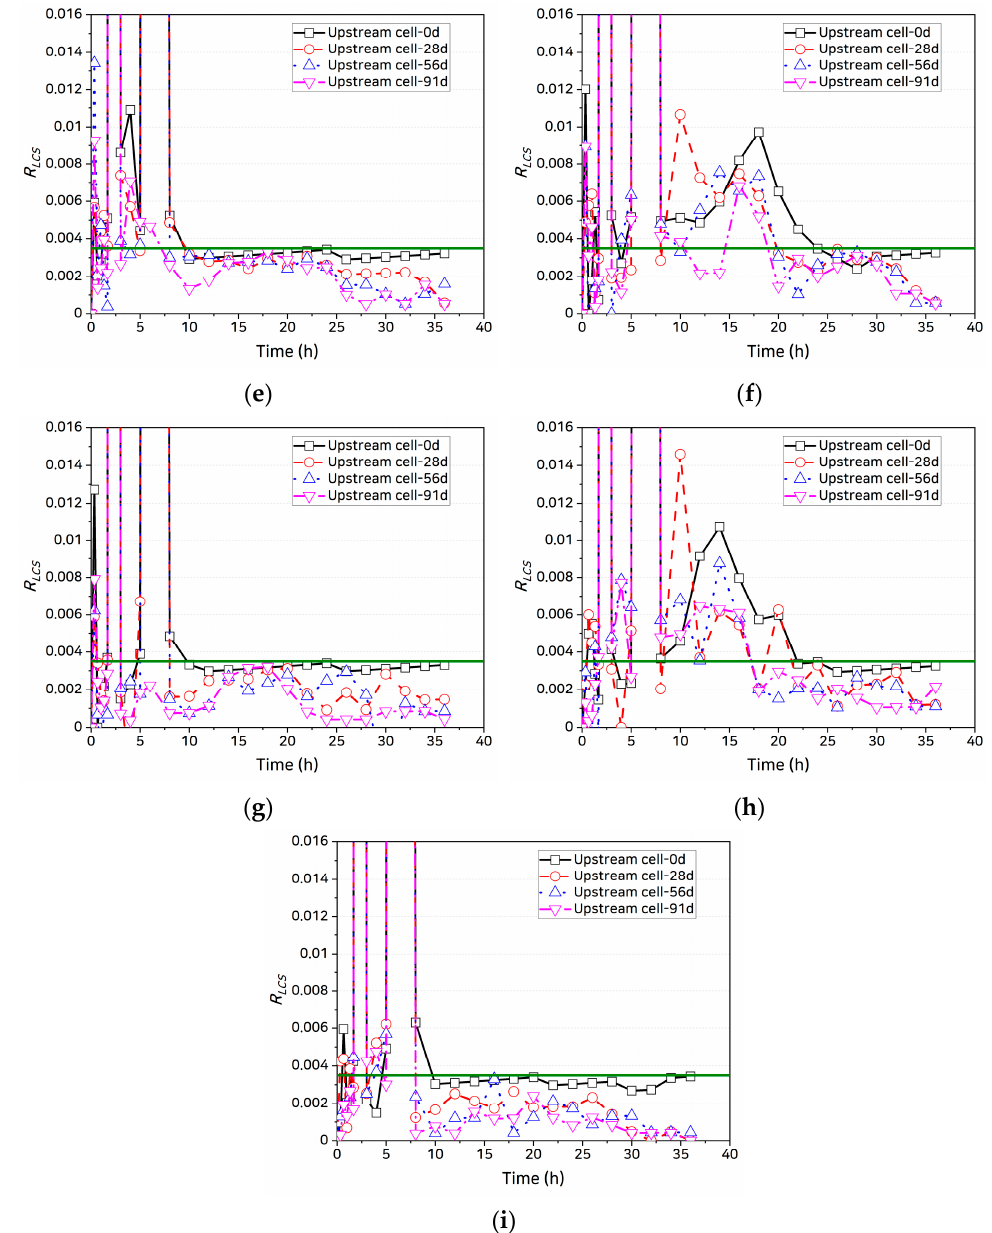
Figure 5. Variation in rate of change of chloride concentration: ( a ) OPC, uncracked; ( b ) SHC15, uncracked; ( c ) SHC30, uncracked; ( d ) OPC, crack width 0.3 mm, uncoated; ( e ) OPC, crack width 0.3 mm, uncoated; ( f ) SHC15, crack width 0.3 mm, uncoated; ( g ) SHC15, crack width 0.3 mm, coated; ( h ) SHC30, crack width 0.3 mm, uncoated; and ( i ) SHC30, crack width 0.3 mm, coated.